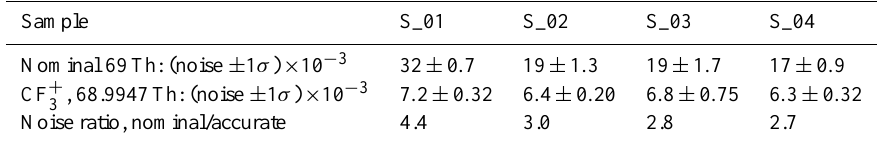
Table 4. Inter-sample comparison of noise levels on nominal mass (69 ± 0 . 3)Th and accurate mass 68 . 9947 ± 0 . 025Th (CF + different samples. Both signals were extracted from the same raw data as described in Sect. 2.4. Noise levels were calculated as means over five measurements per sample on a baseline section from 870 to 895 s chromatographic time. Errors given as the corresponding 1-fold standard deviations. All samples were measured in one measurement series with constant sample volume and the same MS